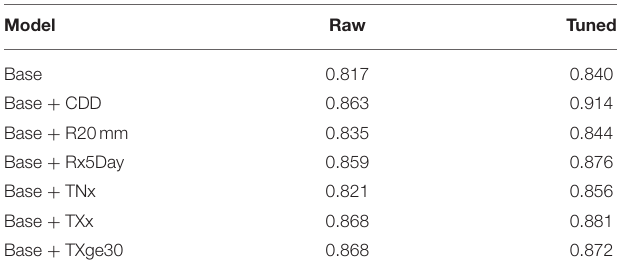
TABLE 2 | Accuracy assessment of the crop suitability modeling using AUC values obtained from base variables and extreme variables from independent test